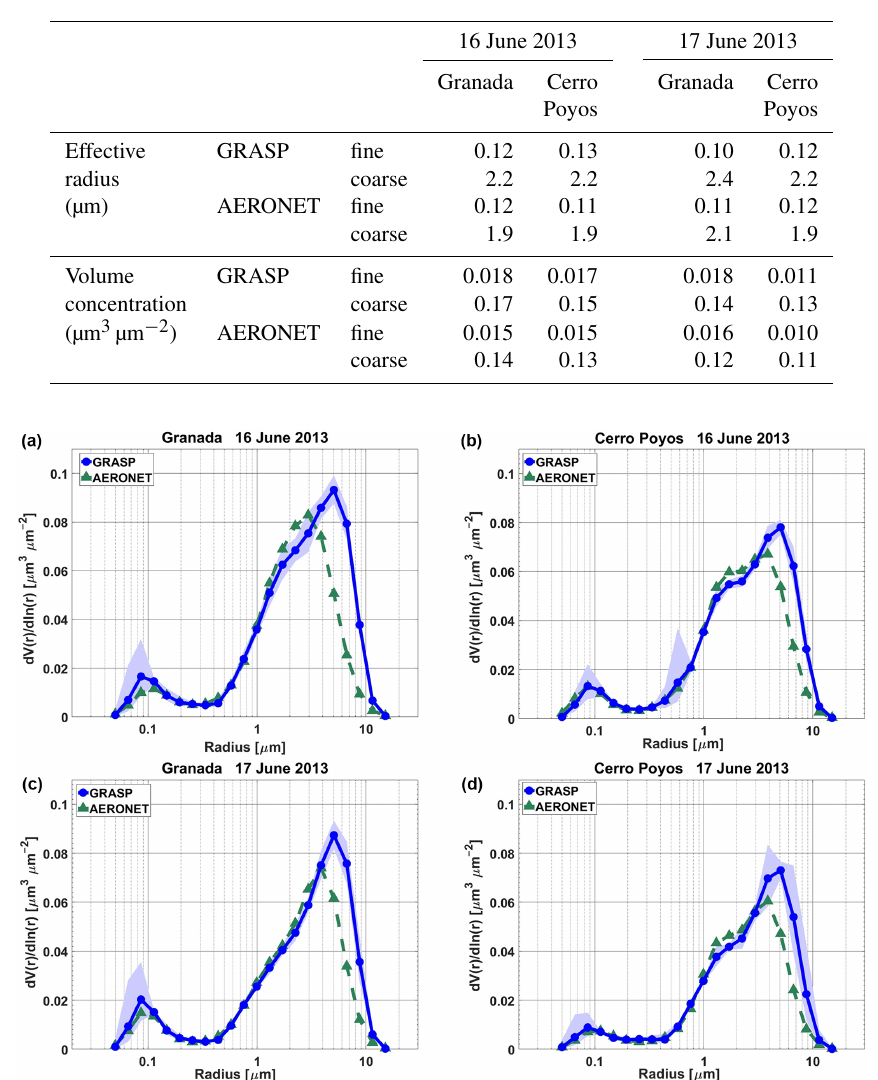
Table 3. Columnar effective radius and particle volume concentration for coarse and fine particle modes retrieved by GRASP and AERONET algorithms.